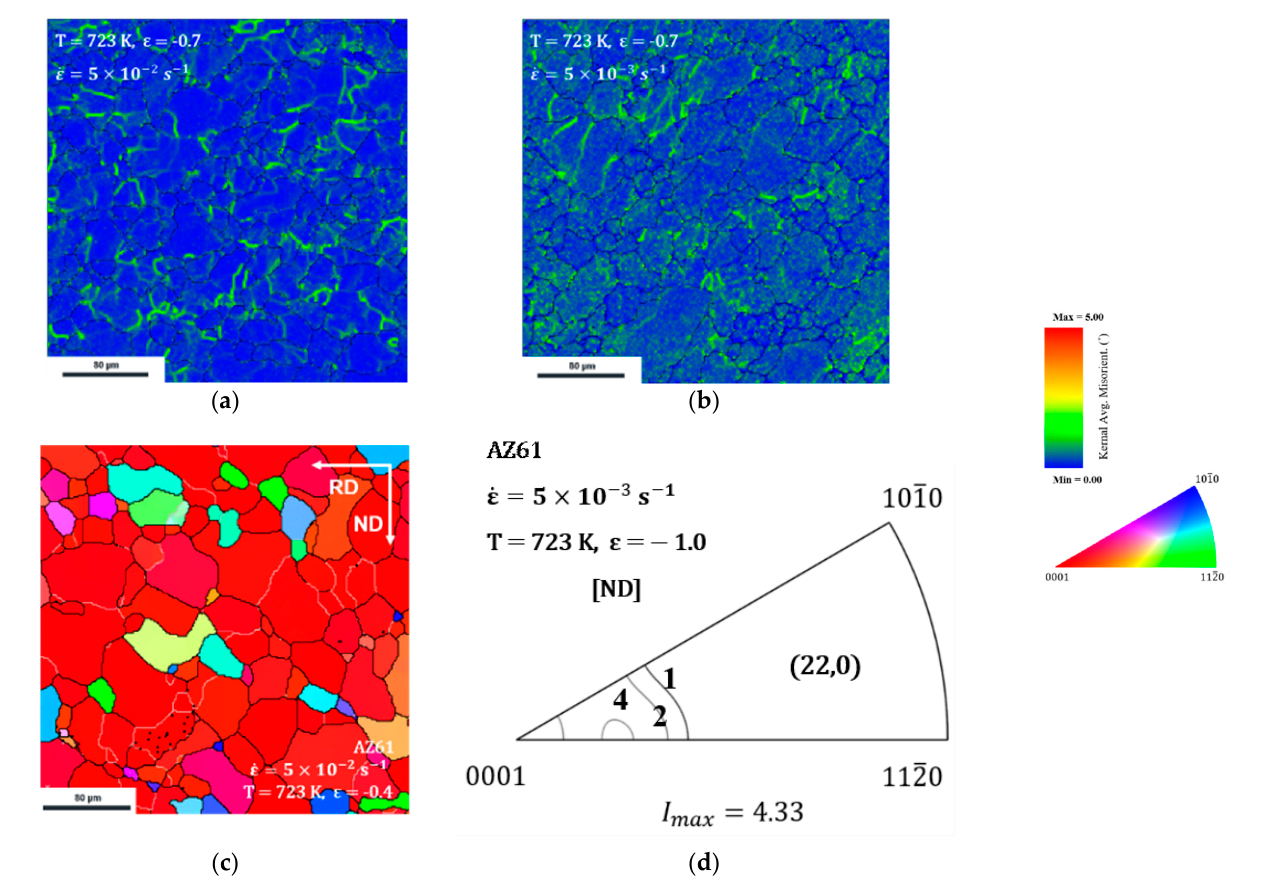
Figure 6. The KAM map of AZ61 specimen after deformation at the ( a ) high and ( b ) low strain rate, ( c ) the microstructure of AZ61 after deformation strain up to − 0.4 and ( d ) texture of specimen after deformation in the low strain.